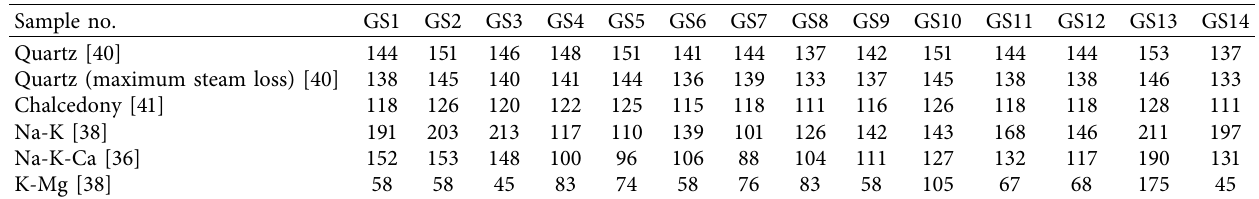
Table 3: Geothermometer calculations of the geothermal waters (unit: ° C). Sample no.